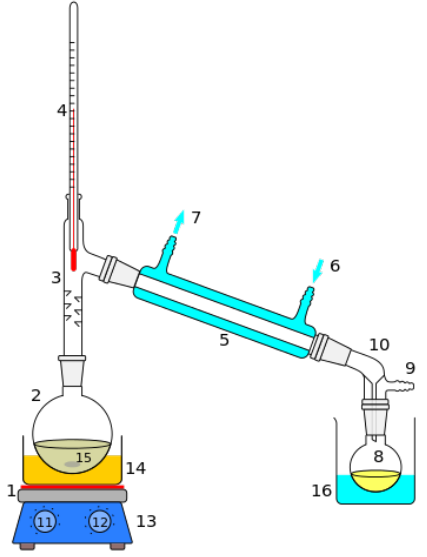
Figure 1. Scheme of the used laboratory distilling setup